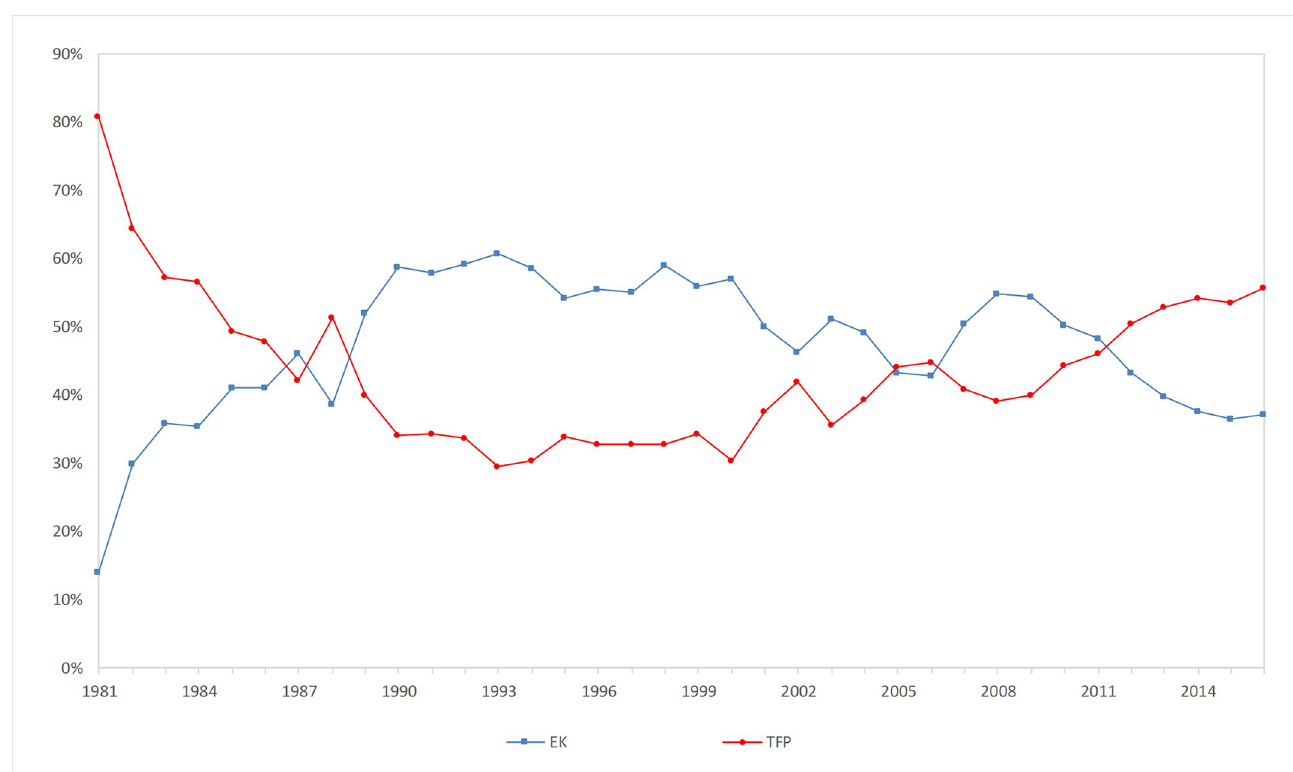
Fig 6. Trends of total factor productivity and capital contribution